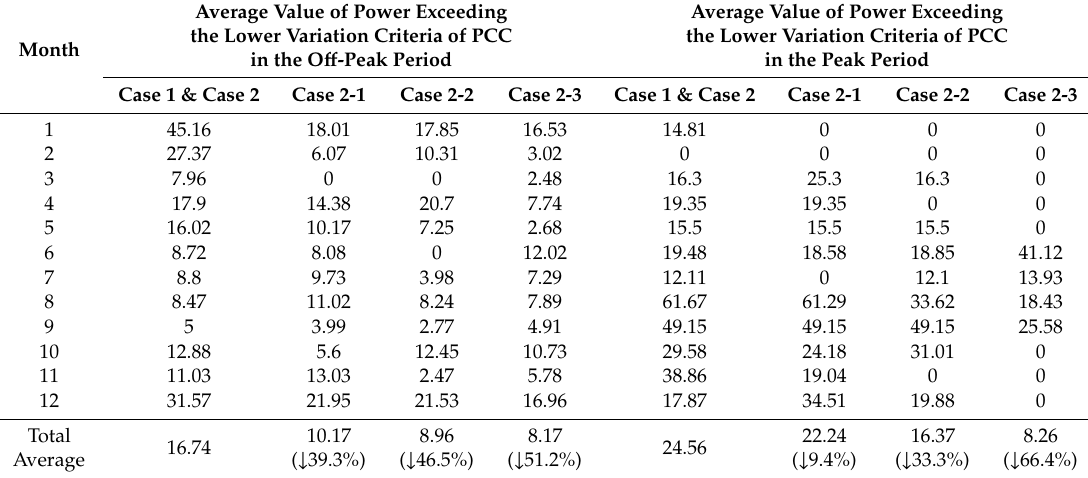
Table 6. Monthly power exceeding the lower variation criteria of the point of common coupling (PCC) in o ff -peak and peak